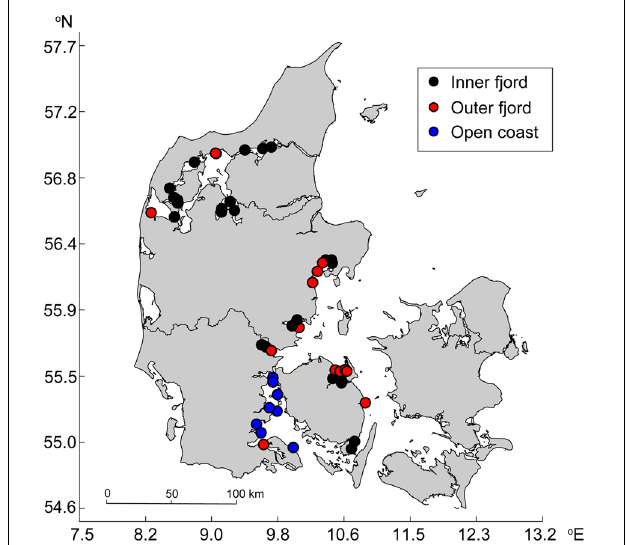
FIGURE 1 | Map showing the sites and their respective waterbody